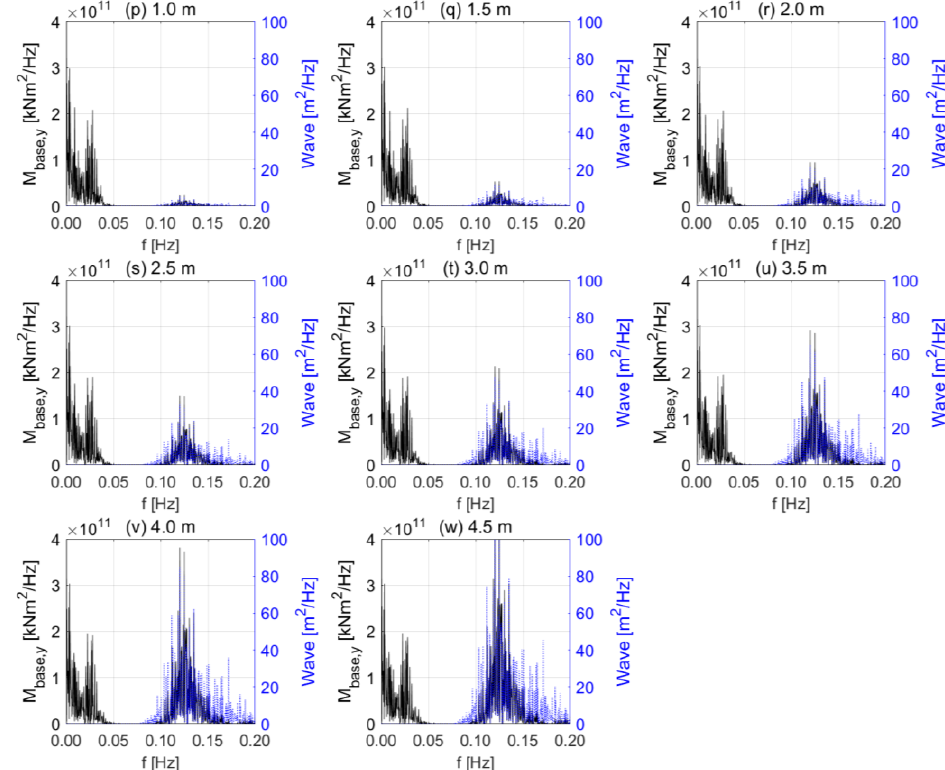
Figure 11. FFT results of tower-base pitch moments (black) and waves (blue) according to significant wave height.